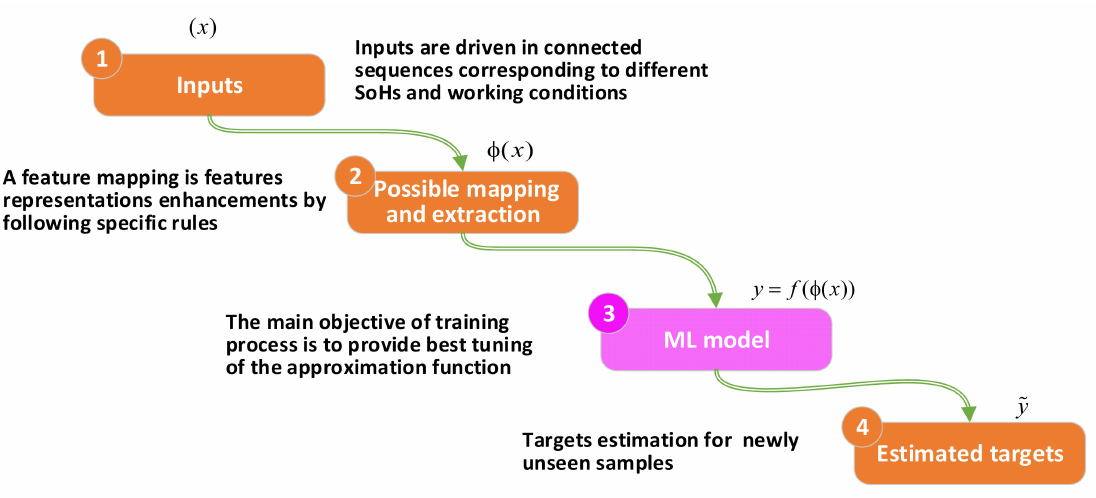
Figure 11. Different steps to solve a supervised learning problem with conventional ML